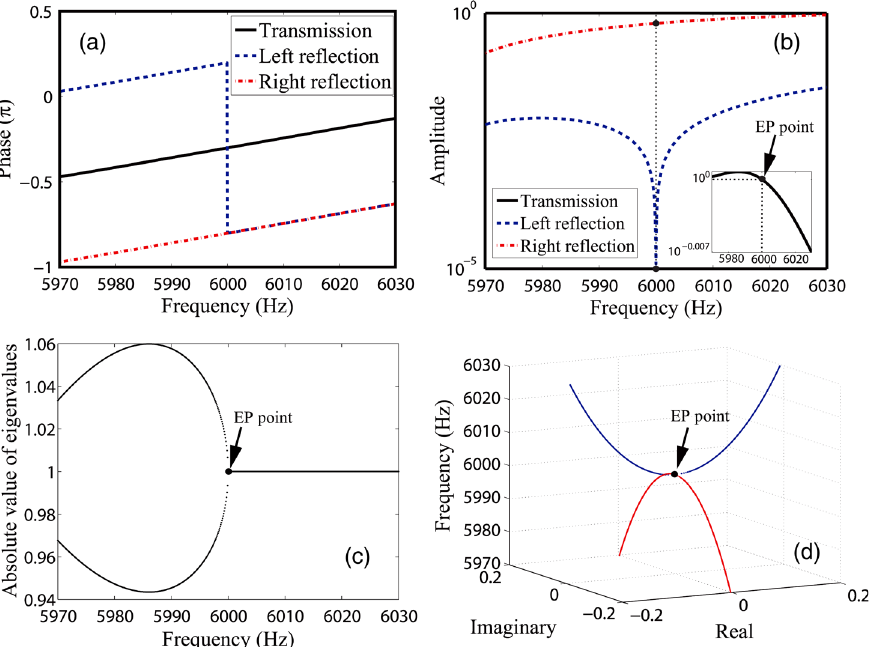
FIG. 2. Phases and amplitude of left-reflected, right-reflected, and transmitted waves of the acoustic PT -symmetric medium are shown in (a) and (b), respectively. The absolute value of the eigenvalues and the second component of the eigenvectors of the corresponding scattering matrix for this acoustic PT -symmetric medium are shown in (c) and (d). Here, we have normalized the eigenvectors such that the first component is always